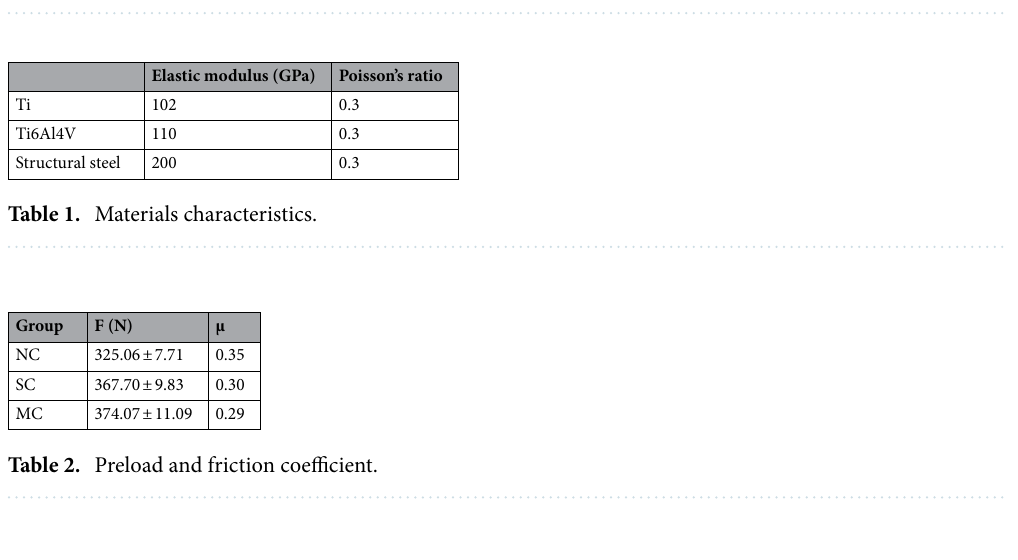
Figure 3. Crown, abutment, abutment screw, implant, and fixture: ( A ) 3D models; ( B ) structure of the finite element model.